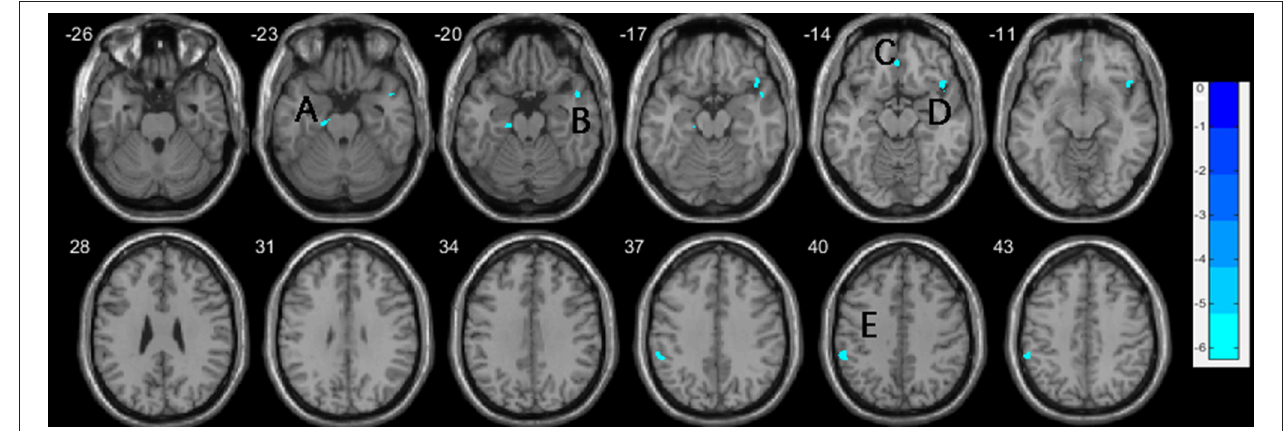
FIGURE 2 | Decreases of gray matter volume in the nvSZ group compared to HCs, with age, education, and TIV controlled. (A) left parahippocam pal gyrus; (B) right temporal Pole: superior temporal gyrus; (C) right rectus, extending to bilateral medial orbital frontal gyrus; (D) right inferior frontal gyrus, orbital; (E) left inferior parietal lobe. TIV, total intracranial volume.